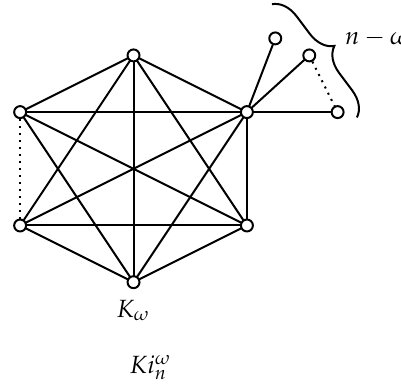
Figure 2. The short kite graph Ki ω n